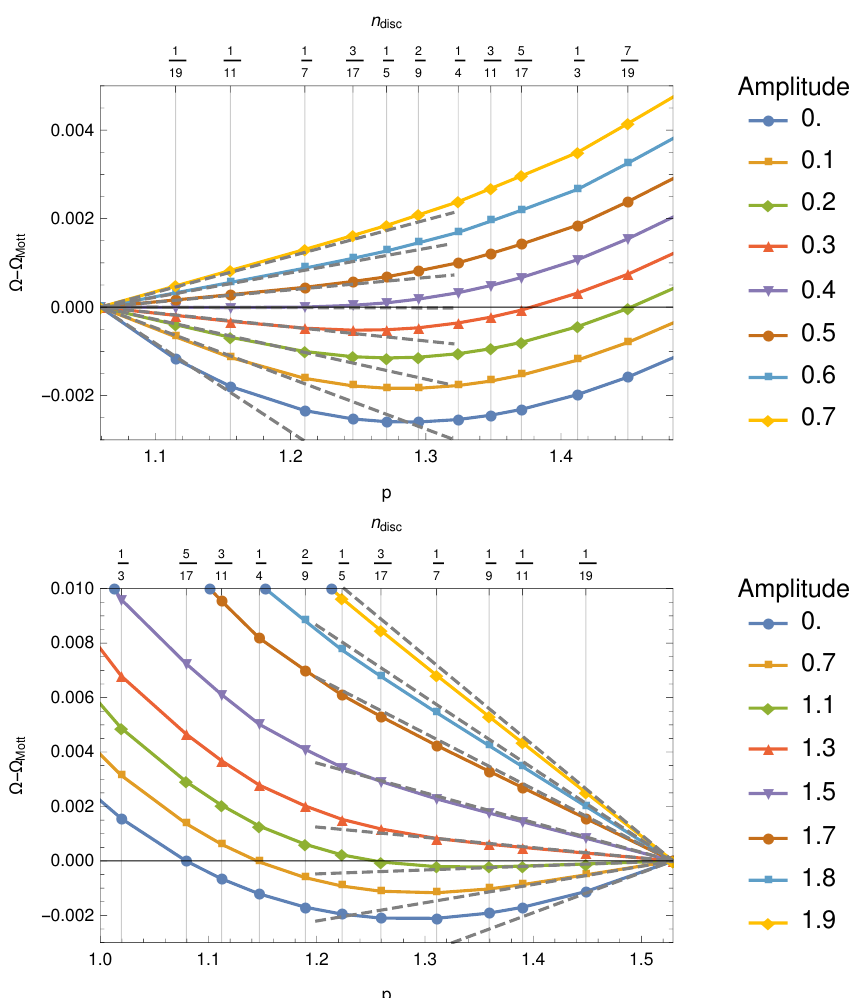
Figure 8 . Thermodynamic potential as a function of the density of discommensurations, measured with respect to the commensurate state at di(cid:11)erent amplitudes of the lattice. For temperature T = 0 : 01 the spontaneous momentum is p 0 ( T ) = 1 : 28. Upper panel shows the case when the lattice momentum is smaller: k = 1 : 06 < p 0 , and positive discommensurations increase the total momentum of the incommensurate solution. Lower panel | the lattice momentum is larger k = 1 : 53 > p 0 and negative discommensurations reduce the momentum of incommensurate solution. The slopes of the dashed lines correspond to the mass of a single discommensuraton. When this slope becomes negative, the commensurate state is unstable and the discommensurations